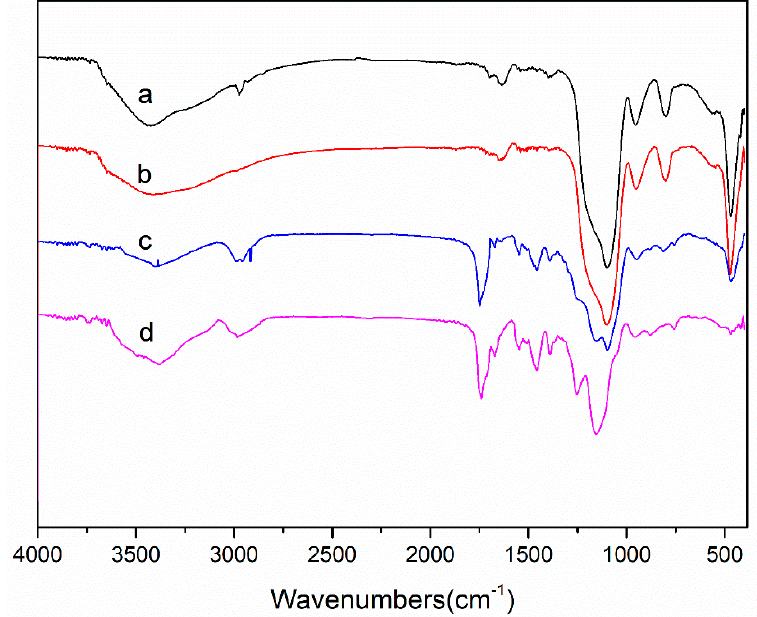
Figure 5. FT-IR spectra of the SiO 2 ( a ), SiO 2 @MPS ( b ), MIPs ( c ), NIPs ( d ).